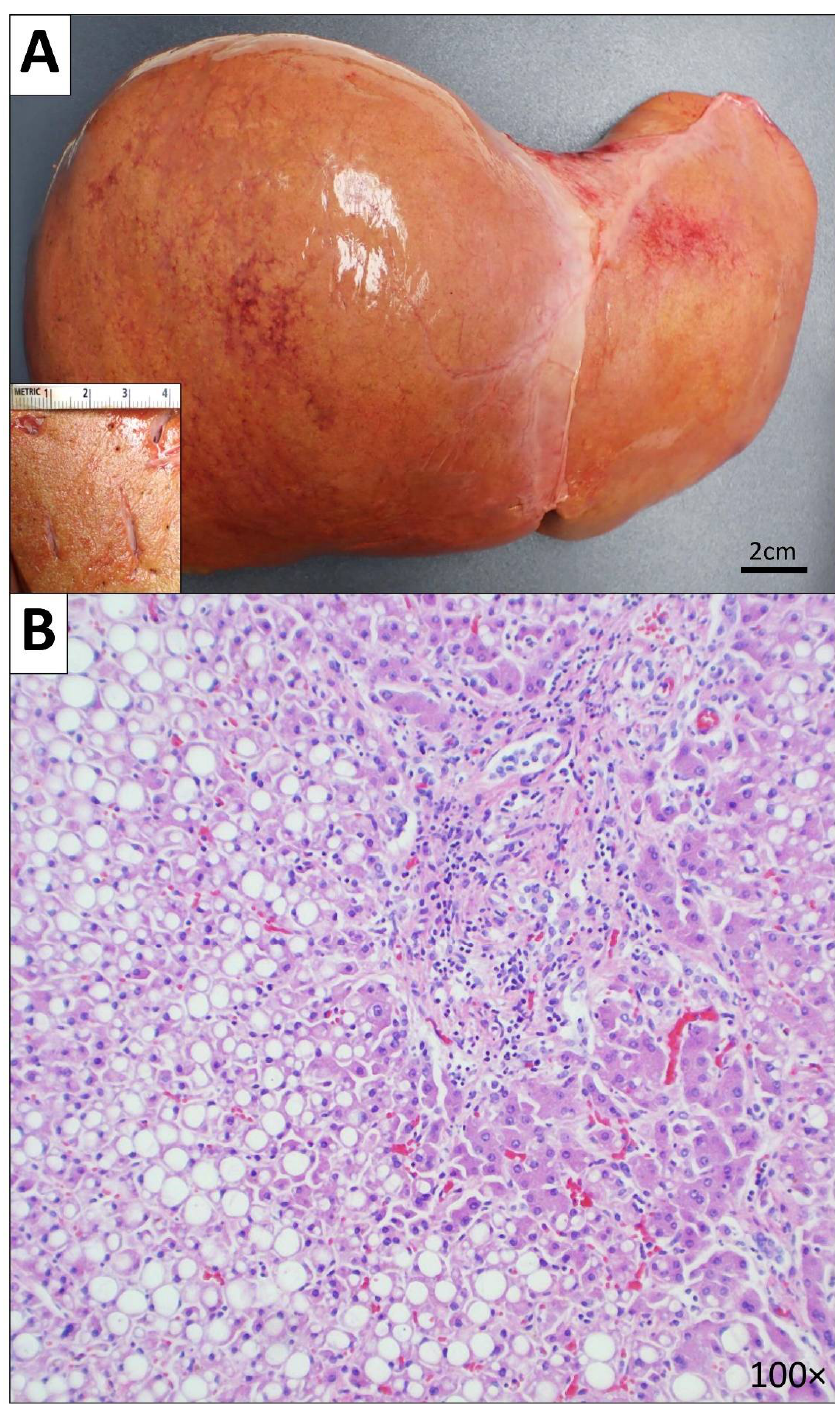
Figure 4. Gross and microscopic images of the liver. ( A ) Gross image of the liver. ( B ) Microscopic image of the liver showing diffuse, severe steatosis with portal, septal and focal bridging fibrosis (stage 3 fibrosis) (100× magnification).